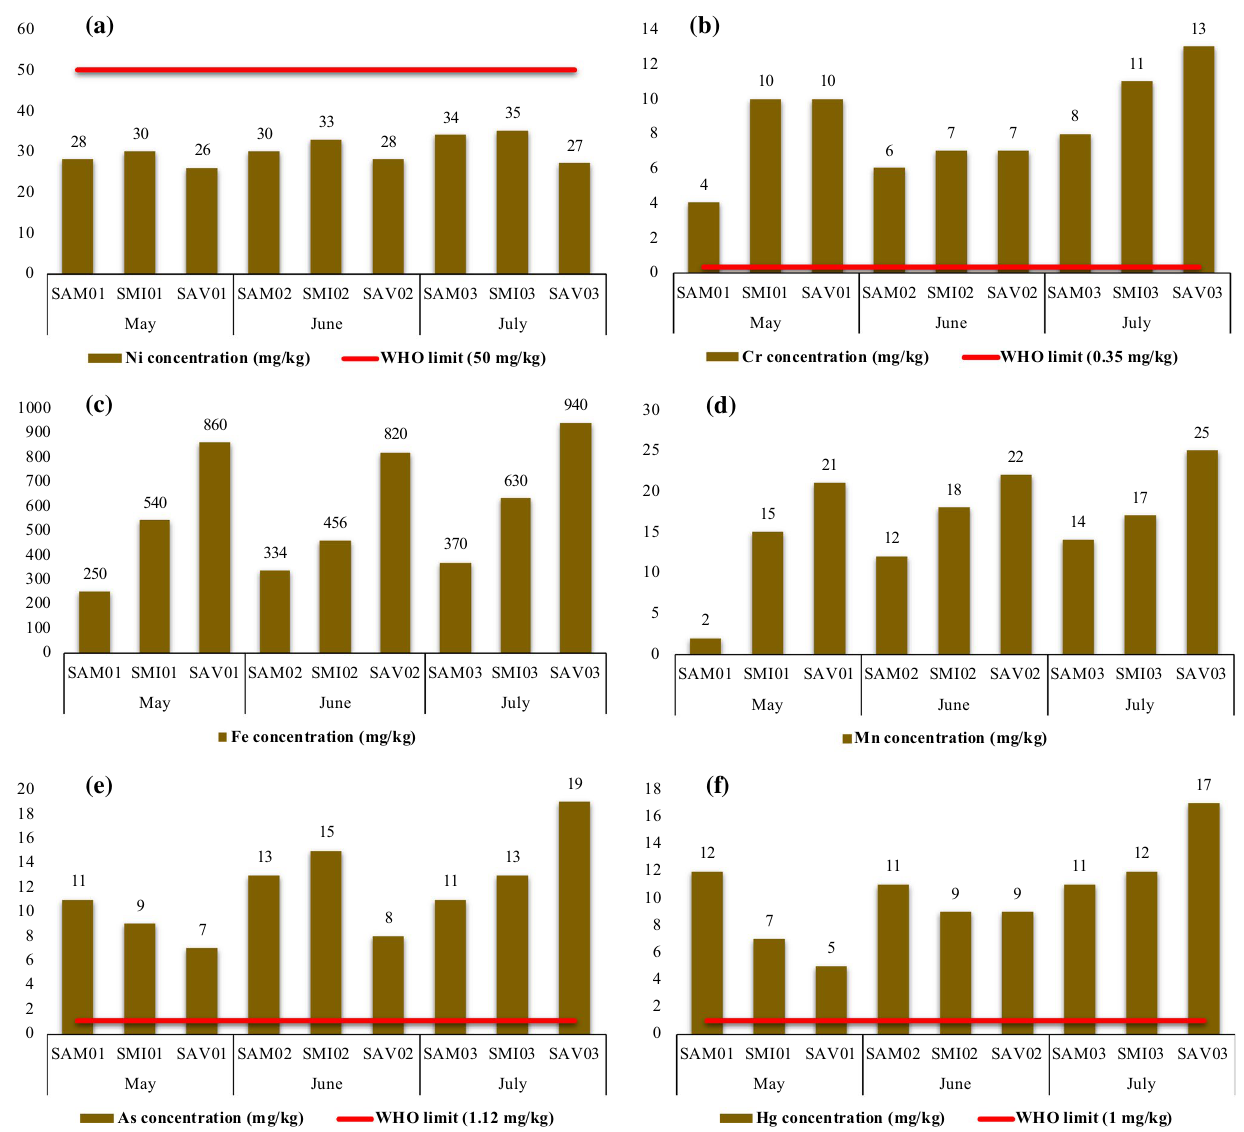
Fig. 6 Spatiotemporal variations in trace metals concentrations in sediment samples: a Nickel; b Cadmium; c Iron; d Manganese; e Arsenic and f Mercury. SAM Usptream sample; SMI Sample collected in the middle of the mining site; SAV Downstream